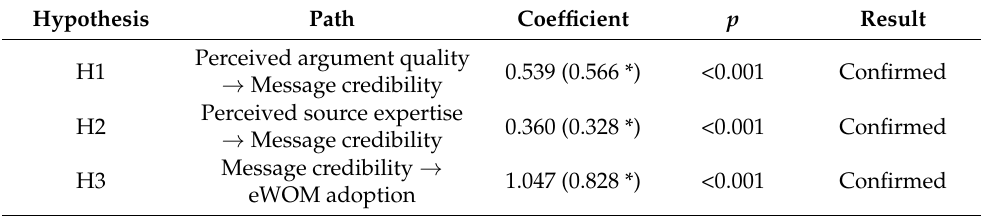
Figure 2. The path coefficients. ** the coefficients marked by ** are significant at a 0.01 level.